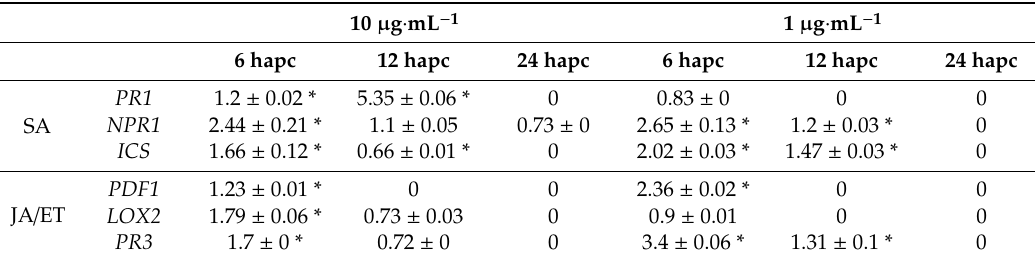
Table 3. Di ff erential gene expression ( A. thaliana seedlings inoculated with the purest fraction at